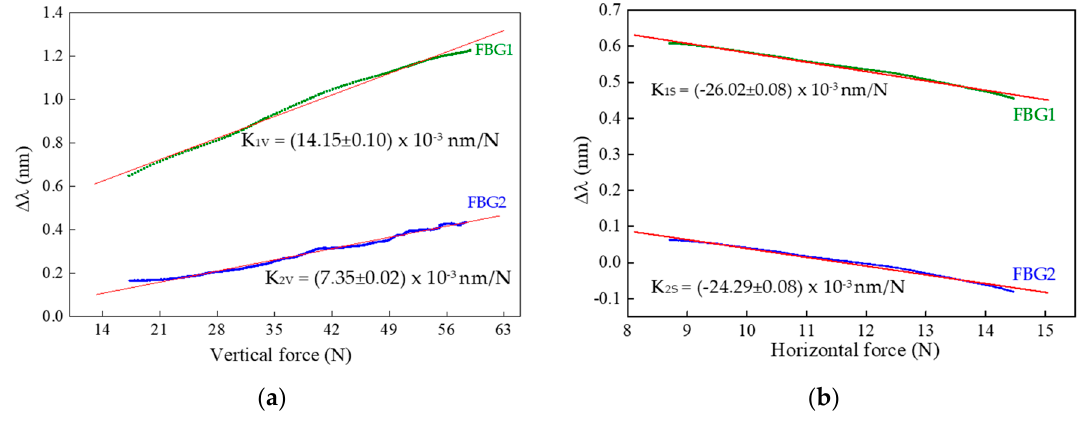
Figure 4. Calibration data obtained for FBG1 and FBG2 during the variation of the applied forces: ( a ) vertical (with ∆ F S ≈ 0 N) and ( b ) shear (with ∆ F V ≈ 0 N). Symbols are the acquired data and the red line corresponds to the linear fit (R 2 > 0.99).